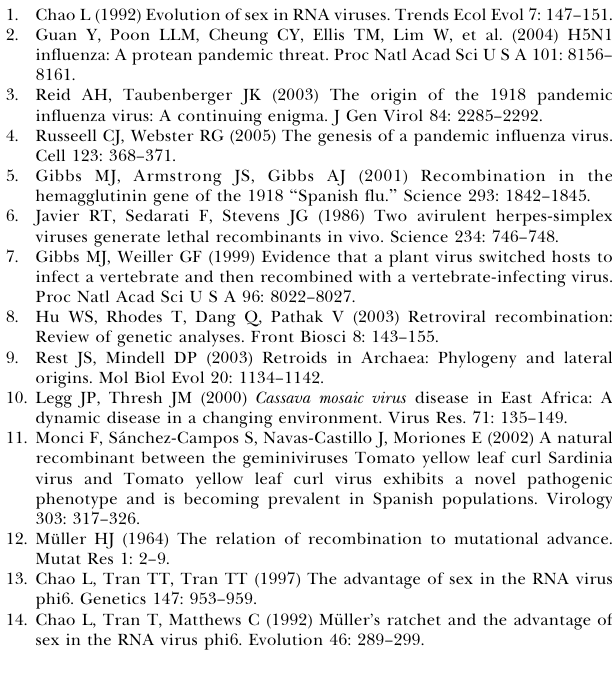
progeny (between brackets). Genotype distribution with the same letter did not differ at a 95% level of confidence. Found at doi:10.1371/journal.ppat.0030008.st002 (65 KB DOC). Table S3. Frequency Distribution of Genetic Types in Progenies from Double Inoculations of IA and IB CMV Isolates on the Systemic Host Nicotiana tabacum cv. Xanthi-nc